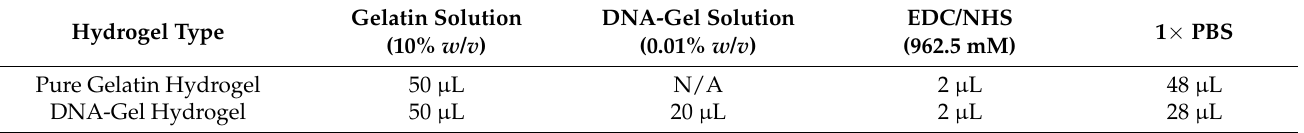
Table 1. Component table for both the pure gelatin hydrogel and DNA-Gel hydrogel. The volume represents the amount needed for 100 µ L of hydrogel, and the initial concentration of each component is shown in parentheses. N/A indicates that the component was not used in the hydrogel. Gelatin Solution DNA-Gel Solution EDC/NHS Hydrogel Type 1 × PBS (10% w / v ) (0.01% w / v ) (962.5 mM) Pure Gelatin Hydrogel 50 µ L N/A 2 µ L 48 µ L DNA-Gel Hydrogel 50 µ L 20 µ L 2 µ L 28 µ